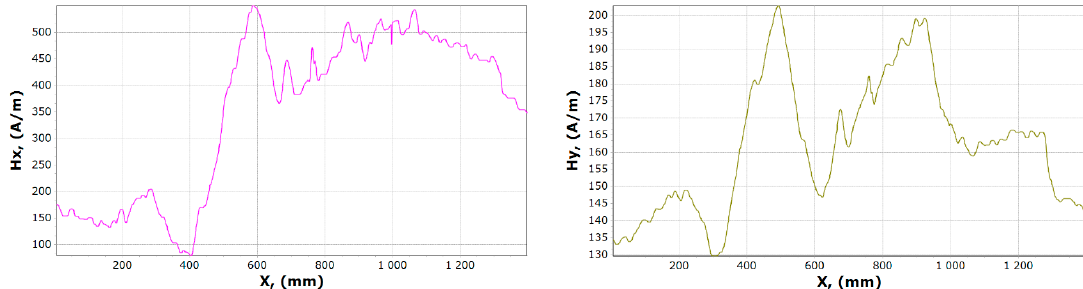
Figure 9. Graphs of tangential Hx and normal Hy component of the magnetic field, for sample 2.